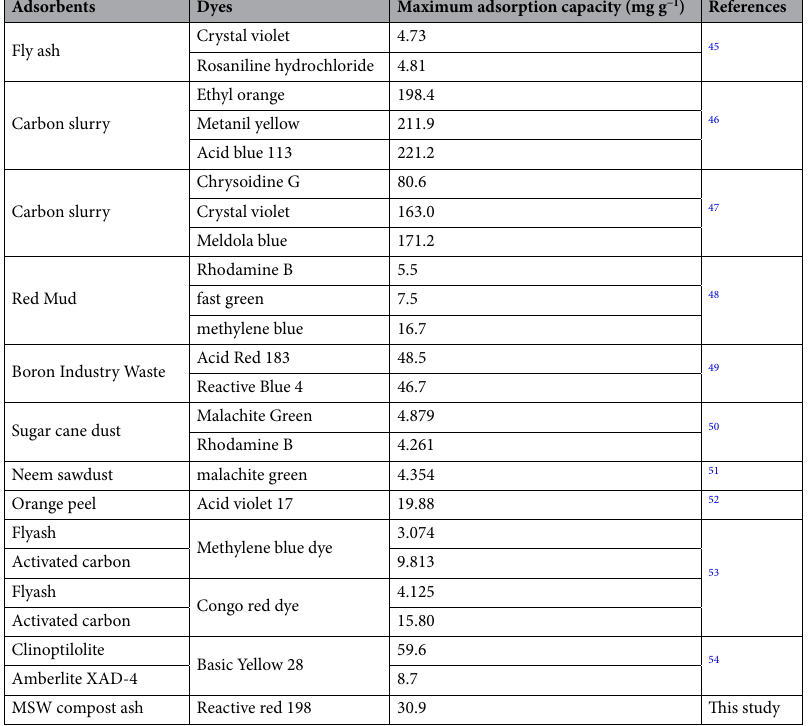
Table 11. Comparison of dye adsorption efficiency of different